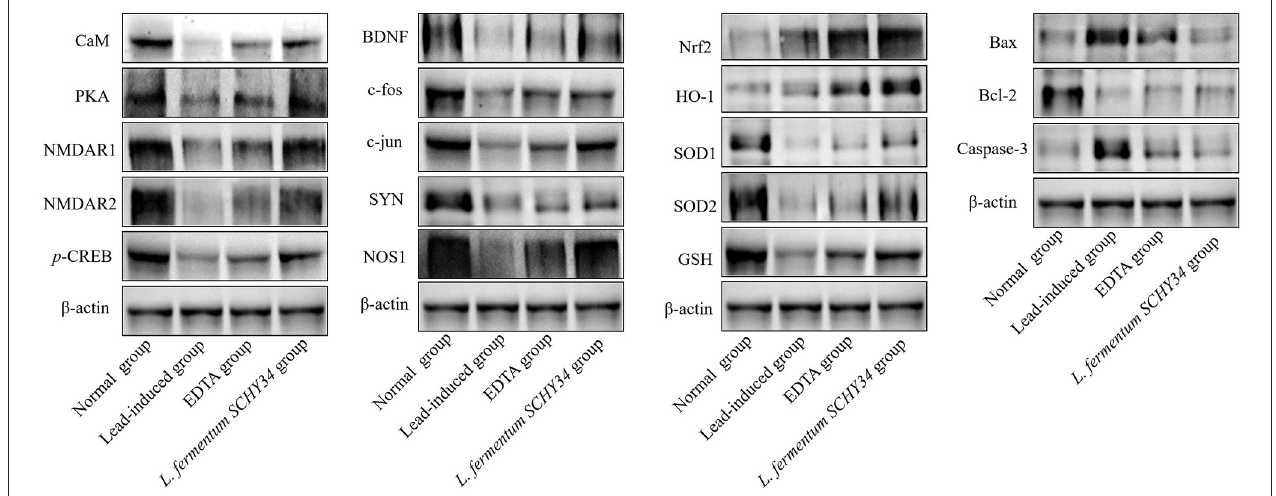
FIGURE 6 | Protein expression in brain tissue of SD